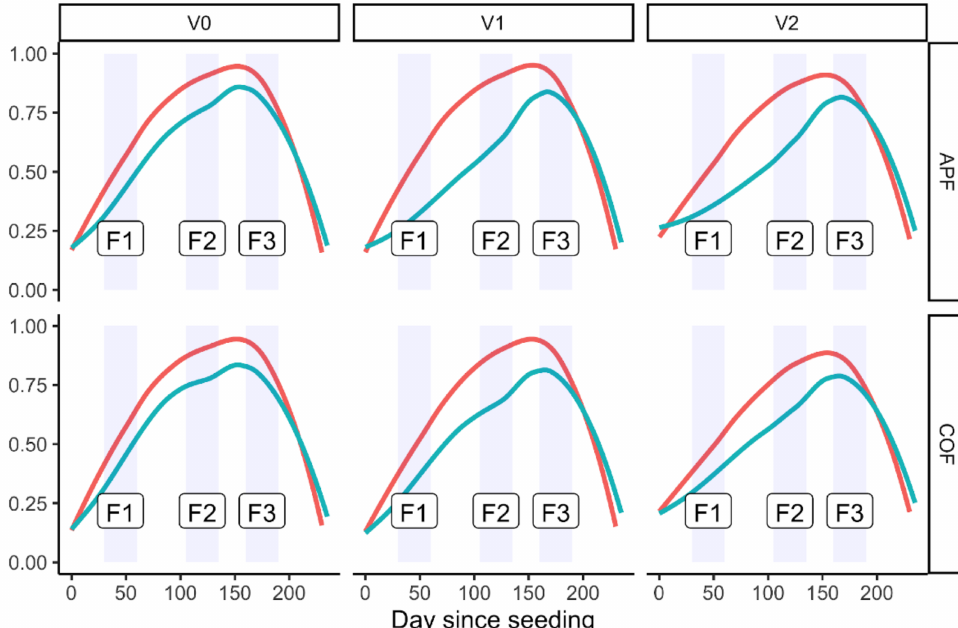
Figure 8. Averaged NDVI during year 1 (red color) and year 2 (cyan color) on each experimental plot defined by the level of vulnerability to flooding (V0, V1, and V2: no, average, and extreme vulnerabil- ity) and by agronomic practice (APF: agroecology, COF: control). Phenological stage windows are shown as shaded boxes labeled F1, F2, F3 (emergence, stem elongation, and flowering phase).